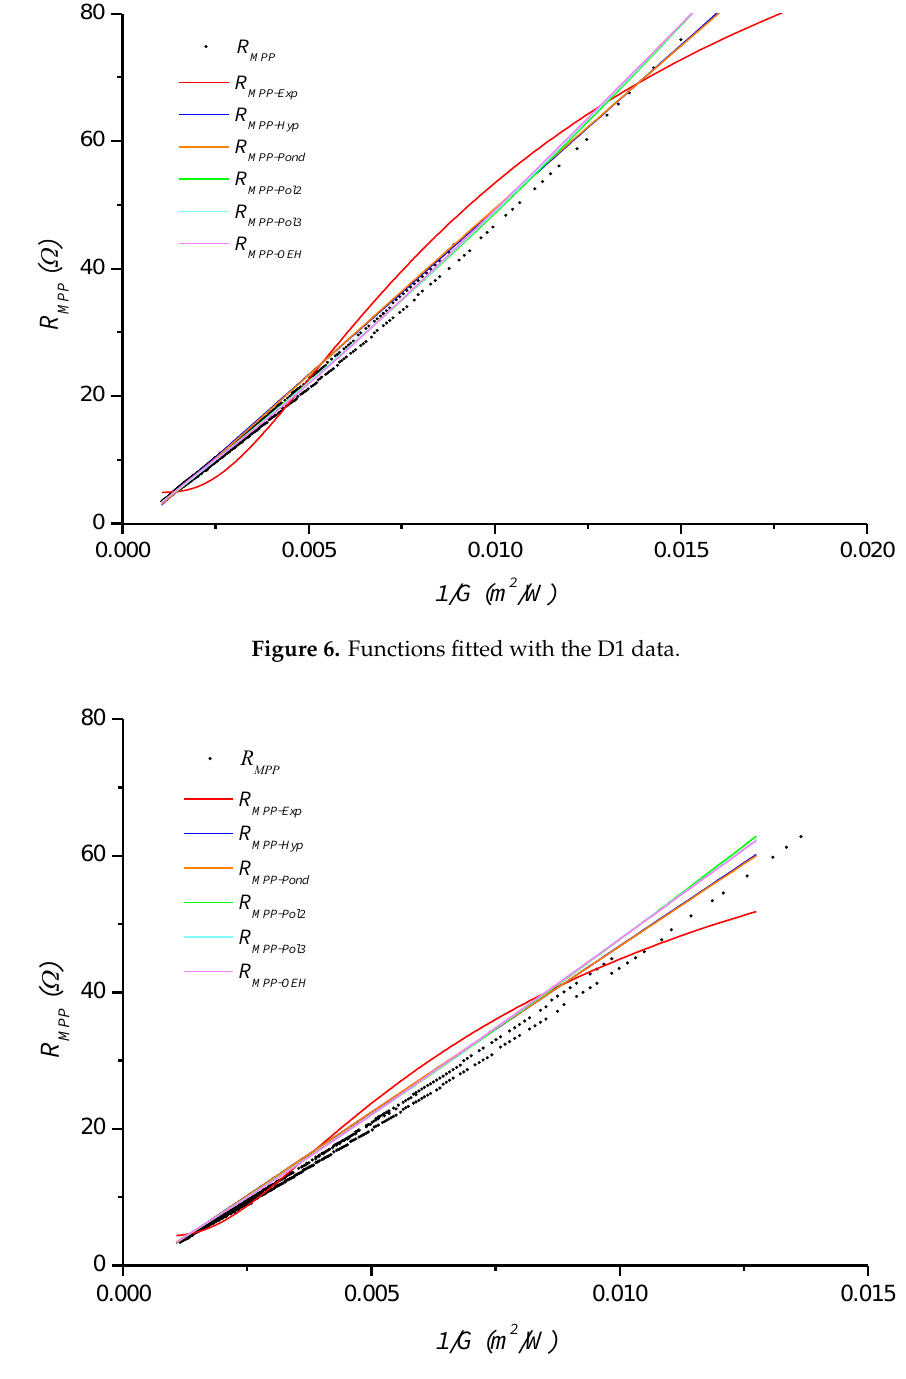
Figure 7. Functions fitted with the D1 data.